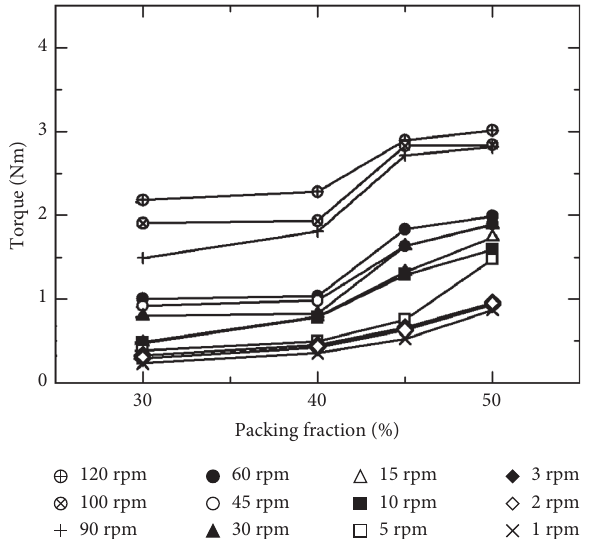
Figure 11: The torque versus packing fraction curve of the rotary damper with gap between the rotor and cylinder using 3mm di- ameter particle made from